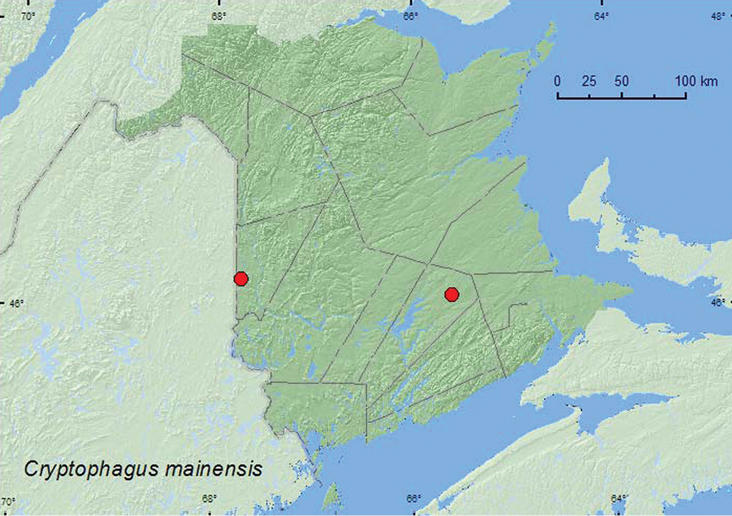
Collection localities in New Brunswick, Canada of Cryptophagus mainensis.